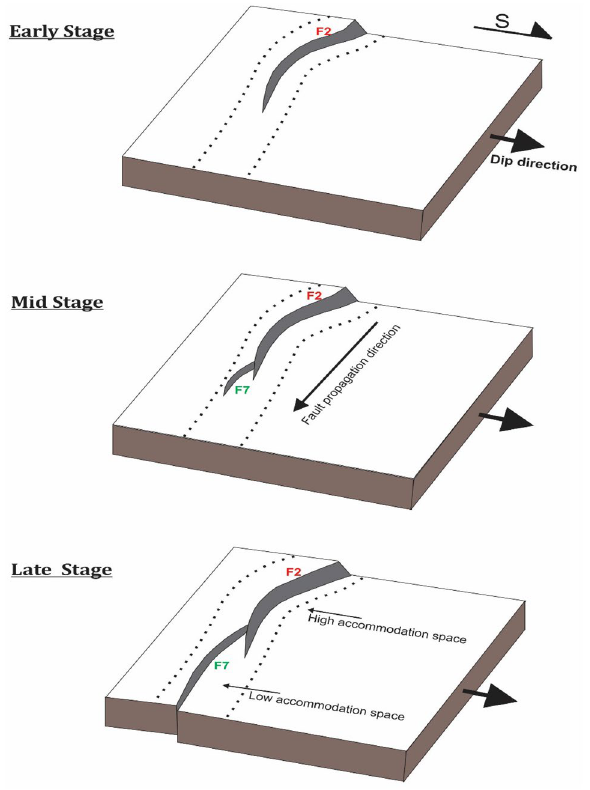
Fig. 17 3D view of segment A showing the evolution and propaga- tion of fault from east to west direction (precursor faults result in higher accommodation space, while newly initiated fault results in lower accommodation space)